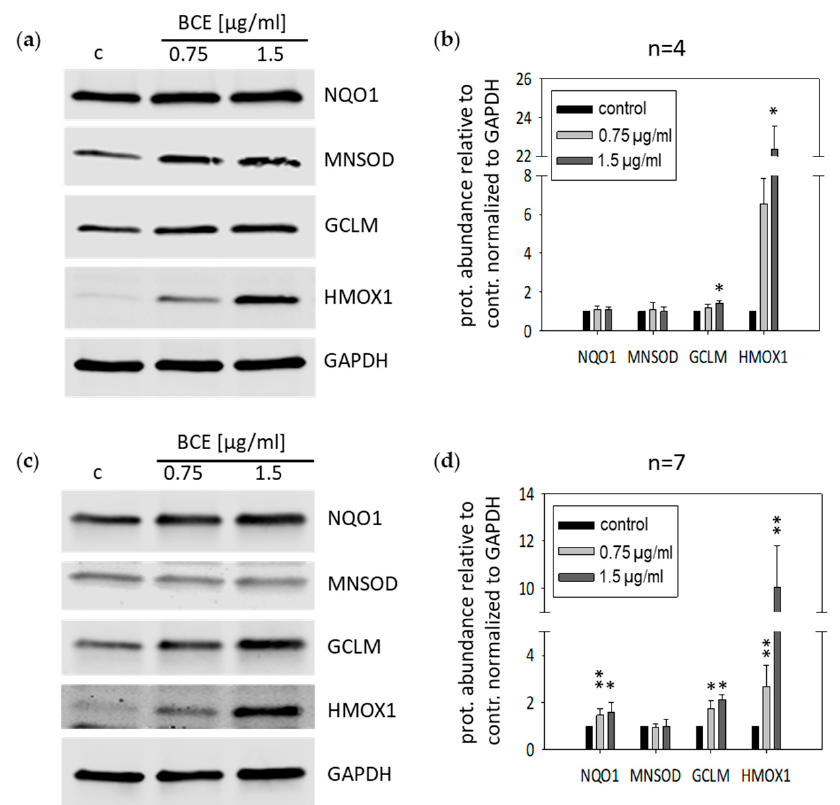
Figure 3. BCE affects protein expression of HMOX1, GCLM and NQO1 in HeLa and EA.hy926 cells. ( a ) HeLa, and ( c ) EA.hy926 cells were incubated without and with 0.75 µg/mL and 1.5 µg/mL BCE for 24 h. Expression of the indicated proteins upon BCE treatment was determined by Western blotting. One representative Western blot of four independent experiments with HeLa cells ( a ), and one representative Western blot of seven independent experiments with EA.hy926 cells ( c ) are shown. ( b , d ) Protein abundance was normalized to GAPDH and quantified relative to a control. The data were presented as mean values with standard deviation from four independent experiments with HeLa cells ( b ), and seven independent experiments with EA.hy926 cells (d). * p < 0.05; ** p < 0.01; ( t - test) BCE vs. control sample.